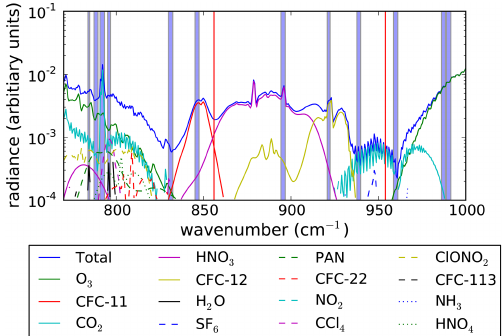
Figure 4. GLORIA tangent points of dynamics-mode measure- ments during ESSenCe flight 2. Tangent points closest (furthest) from the flight path (black line) are at highest (lowest) altitudes. Corresponding tangent altitudes are 4km (red) to 15km (blue). Thick, colored dots mark the geolocation of collocated MIPAS- Envisat and EOS-MLS tangent points and radiosonde positions. MIPAS-Envisat measurements were made on 16 December 2011 at 15:21 and 16:09UTC, and EOS-MLS measurements at 11:40 and 11:42UTC, respectively.